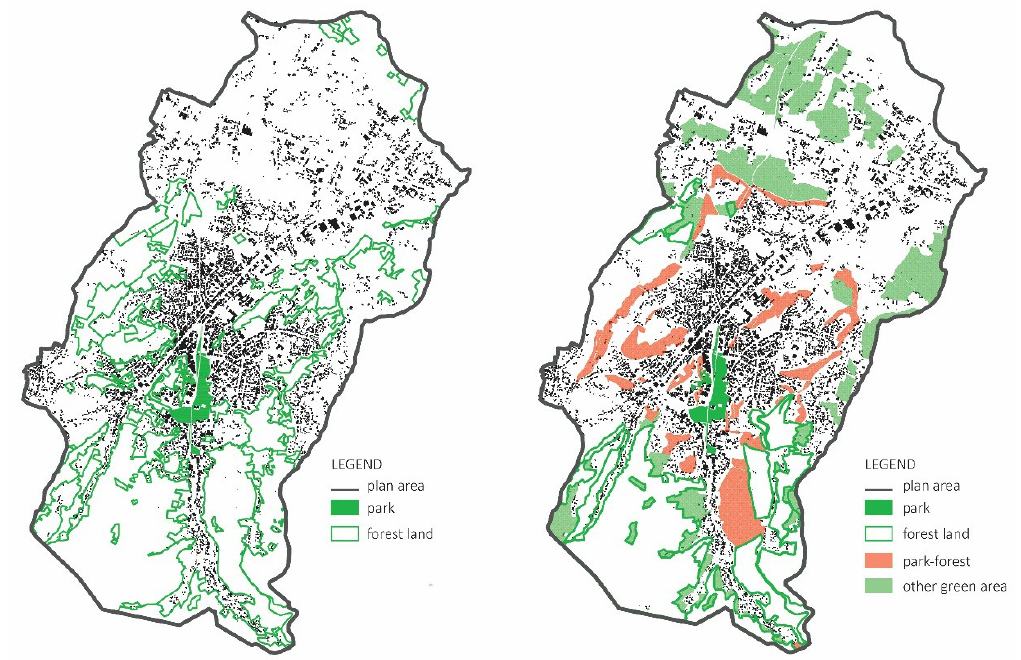
Figure 3. General Zoning Plan for Vrnjačka Banja: green spaces land use plan, current vs. planned state (source: Authors) .